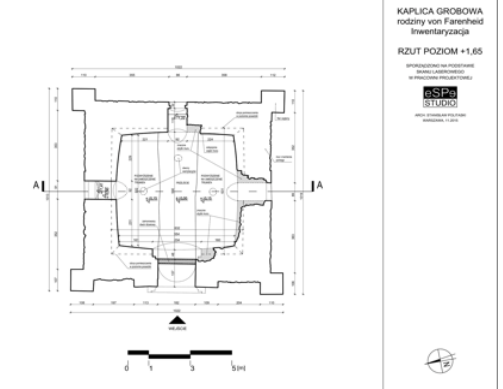
Figure 8. Plan of the pyrmid based on 3D point cloud gathered by TLS scanner (created by S. Politalski) The results of 3D inventory allowed us to contradict the erroneous information which has been included in publications concerning the structure, especially those relating to the height of the building and the chamber within the chapel. The profile of the interior also shows that the internal vaulted ceiling is not formed by sloping walls but rather by four vault cells. It is impossible then to say that the angle of inclination of the walls is the same as that of the Great Pyramid of Giza as has been claimed until now. The only part, which has a similar angle of inclination, is the line at the base of the vault cells forming the ceiling (Politalski 2016) (Fig. 9).